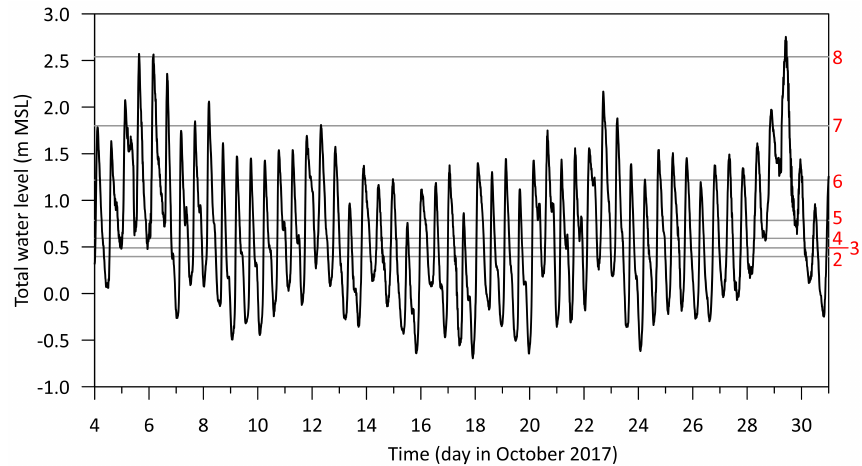
Figure 5. Total water level TWL versus time t . The horizontal lines are the bed level at the groundwater wells, indicated with the red numbers next to right vertical axis, based on the campaign-averaged cross-shore profile. GW3 is GW3-1. The line for GW3-2 is not shown separately as it is about equal to that for GW2, see Figure